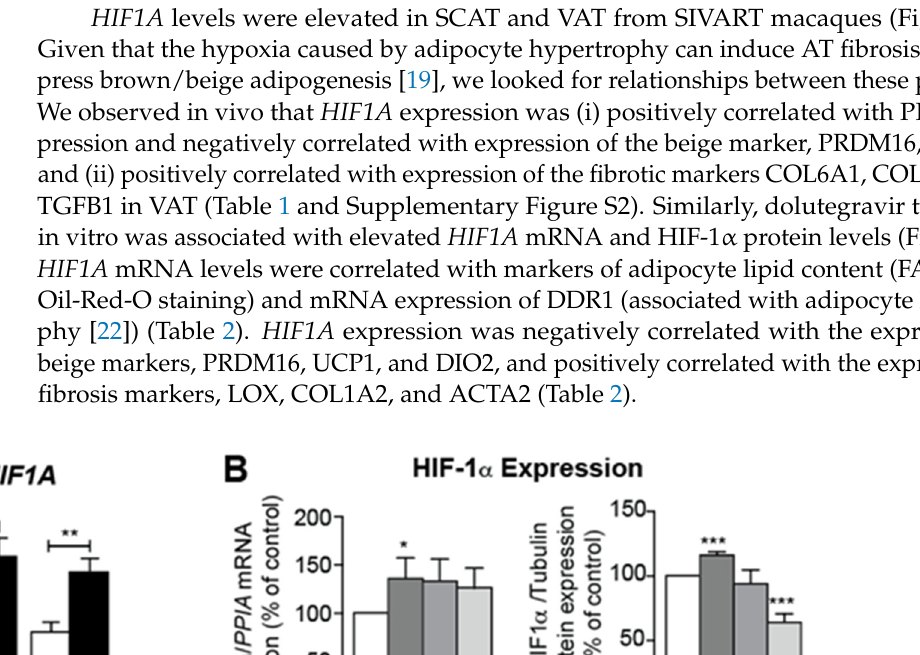
Table 2. Correlations (Pearson’s test) between HIF1A and beiging, fibrosis and lipid accumulation in vitro. Correlation between HIF1A gene expression and beiging-, fibrosis-, and lipid-related gene expression or lipid accumulation in INSTI-treated beige adipocytes. Correlations were determined using PCR data obtained using ASCs ( n = 9).